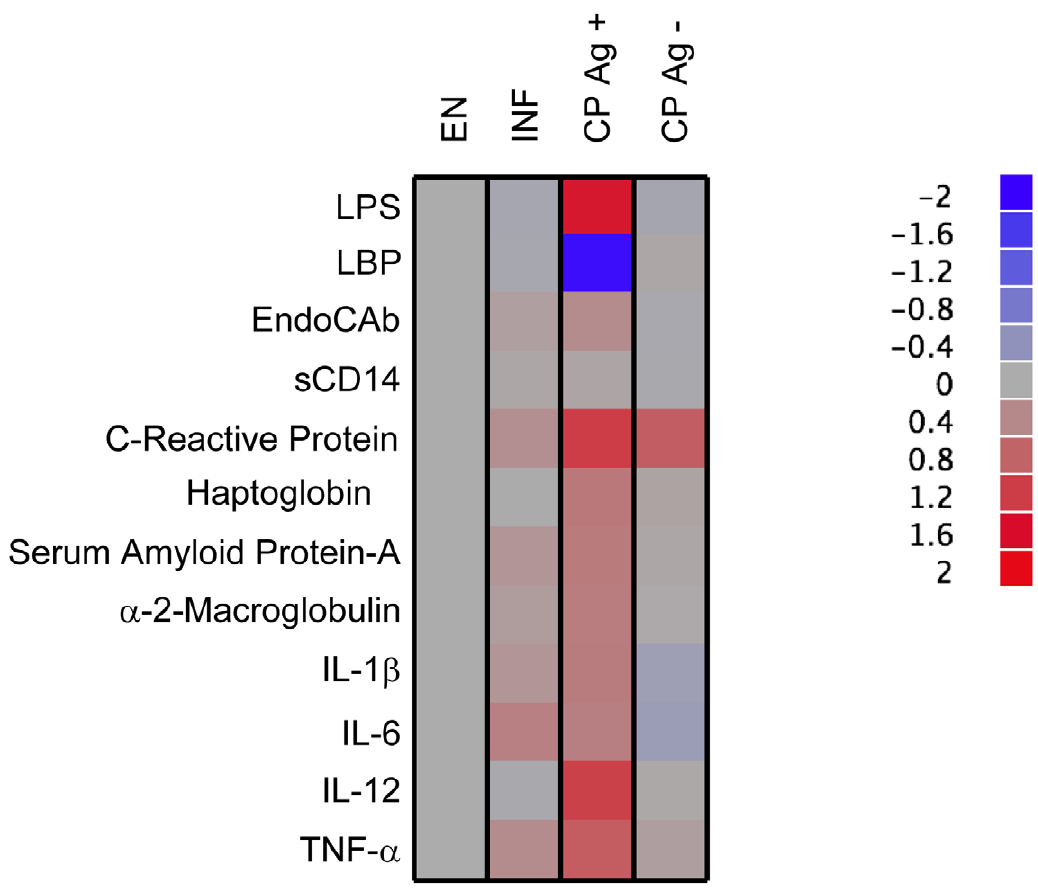
Figure 5. Heatmap depicting circulating microbial products, acute phase proteins and inflammatory cytokines in CP Ag + individuals compared to EN, INF and CP Ag 2 individuals. Data (and scale) are log10 geometric mean fold change from EN for each of the analytes measured for each of the groups.